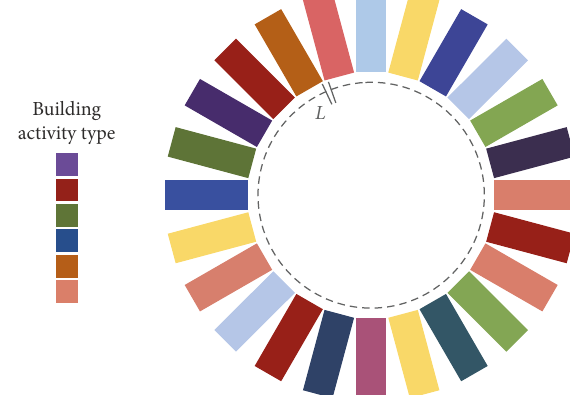
Figure6:Thetheoreticalone-dimensionalcitywithasetofdifferent activity places. Here there are 𝐿 buildings distributed in a ring, constituting the city space. Colors represent activity